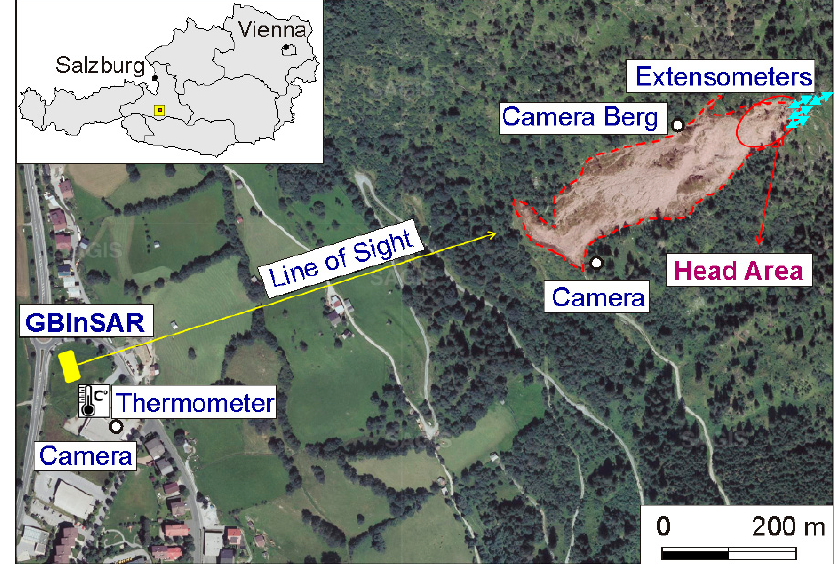
Figure 1. Study area with the location of the Ingelsberg landslide and monitoring systems (base map from SAGIS—Salzburger Geographisches Informations system).